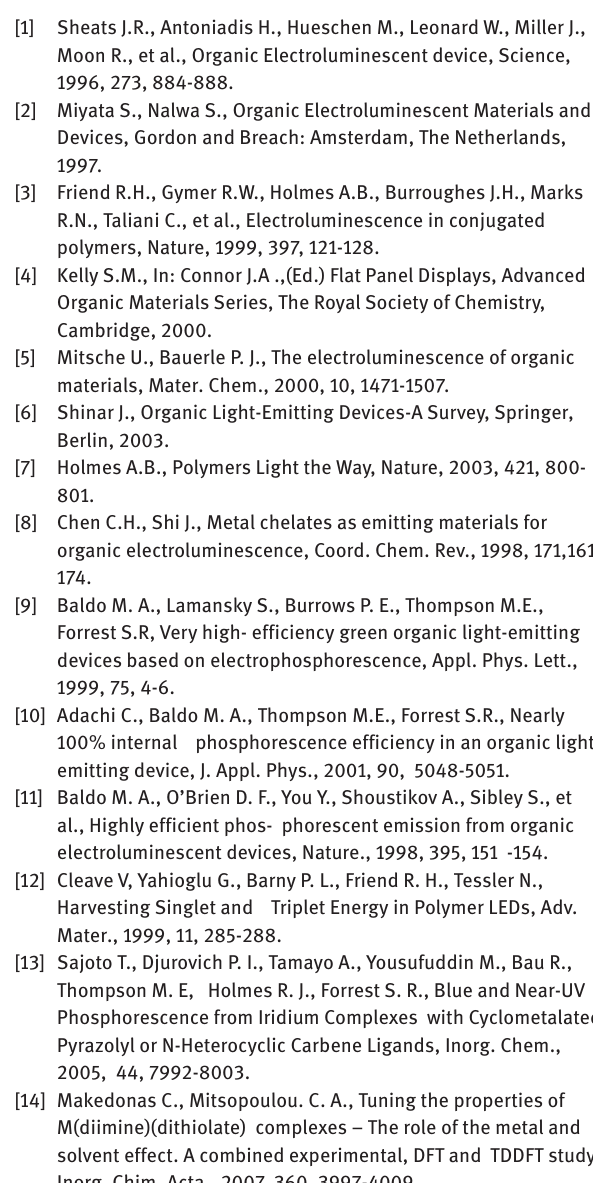
Alq3. Thus these derivatives might be good candidates for emitting materials possessing comparable charge carrier